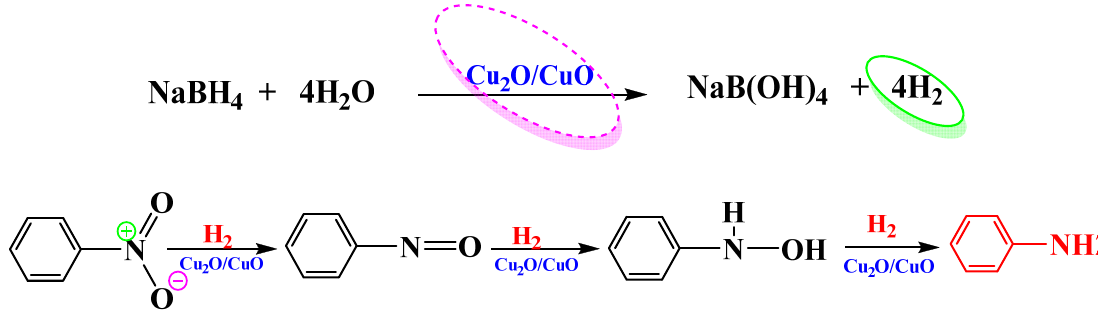
Scheme 1. A presumable mechanism on the reduction of the nitro compound to amino compounds catalyzed by the PSE-capped Cu 2 O/CuO catalyst.